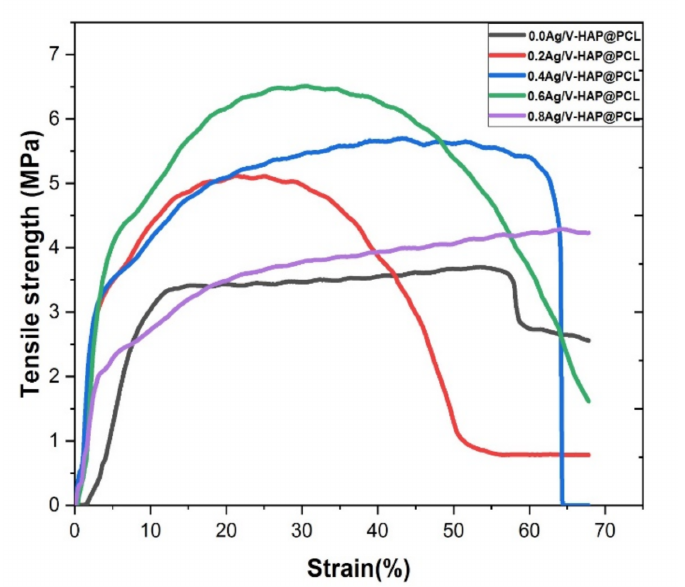
Figure 8. Mechanical properties of PCL scaffolds HAP-modified with co-doped Ag/V and incorpo- rated into